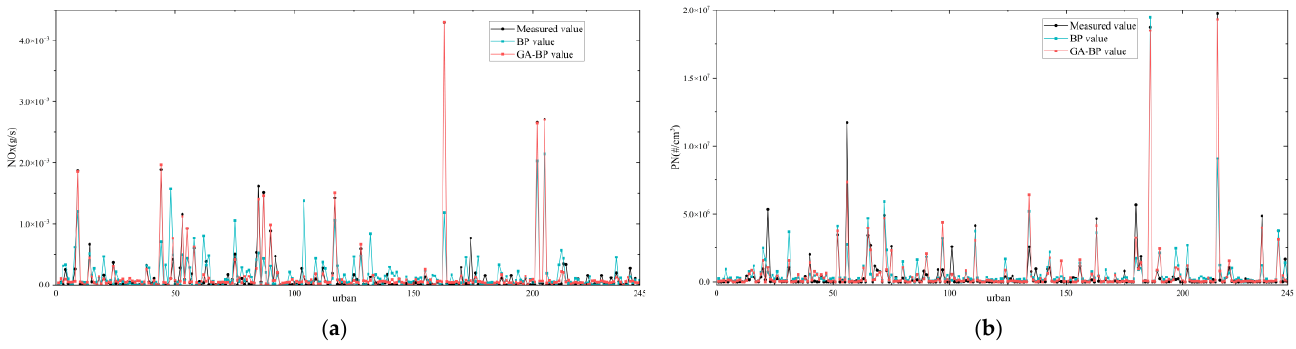
Figure 8. Comparison of the predicted results of BP and GA-BP for NOx and PN in urban areas with the measured values. ( a ) Urban NOx; ( b ) urban PN.